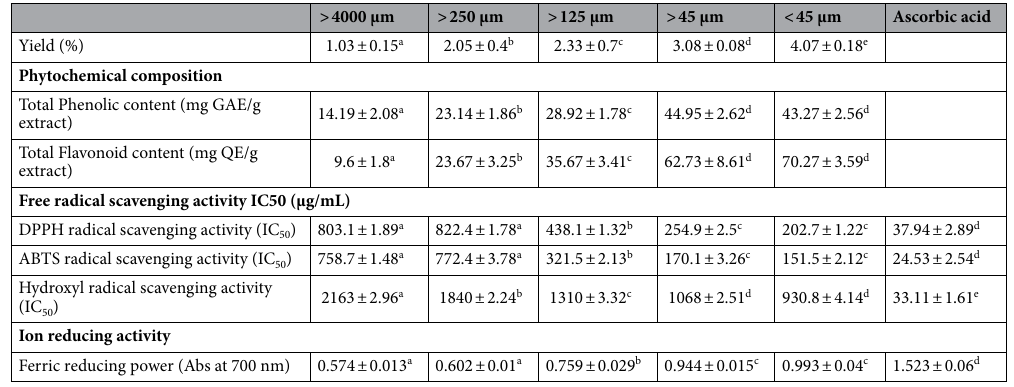
Table 1. Phytochemical composition and antioxidant activity of different sample particle size of S.cristaefolium ethanol extract. Different letters indicating significant difference between columns (p < 0.05).